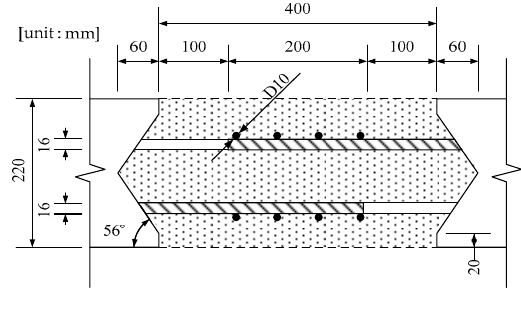
Figure 1. Specifications of the specimen: ( a ) precast module before casting ultra-high-strength concrete (UHSC); ( b ) cross section of A-A; ( c ) modular specimen after casting UHSC.